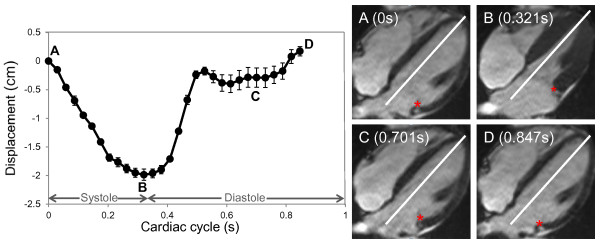
AVJ displacement-versus-time plot and images. Atrioventricular junction motion tracking software interactively measures the longitudinal AVJ position at multiple time points during the cardiac cycle. Error bars represent one standard deviation above and below the mean of multiple independent measurements made on a representative healthy volunteer. Lateral AVJ position, marked with a red asterisk, shown at the start of systole (A), end systole (B), diastasis (C) and end diastole (D) for a representative 4-chamber cine image set. AVJ = atrioventricular junction.